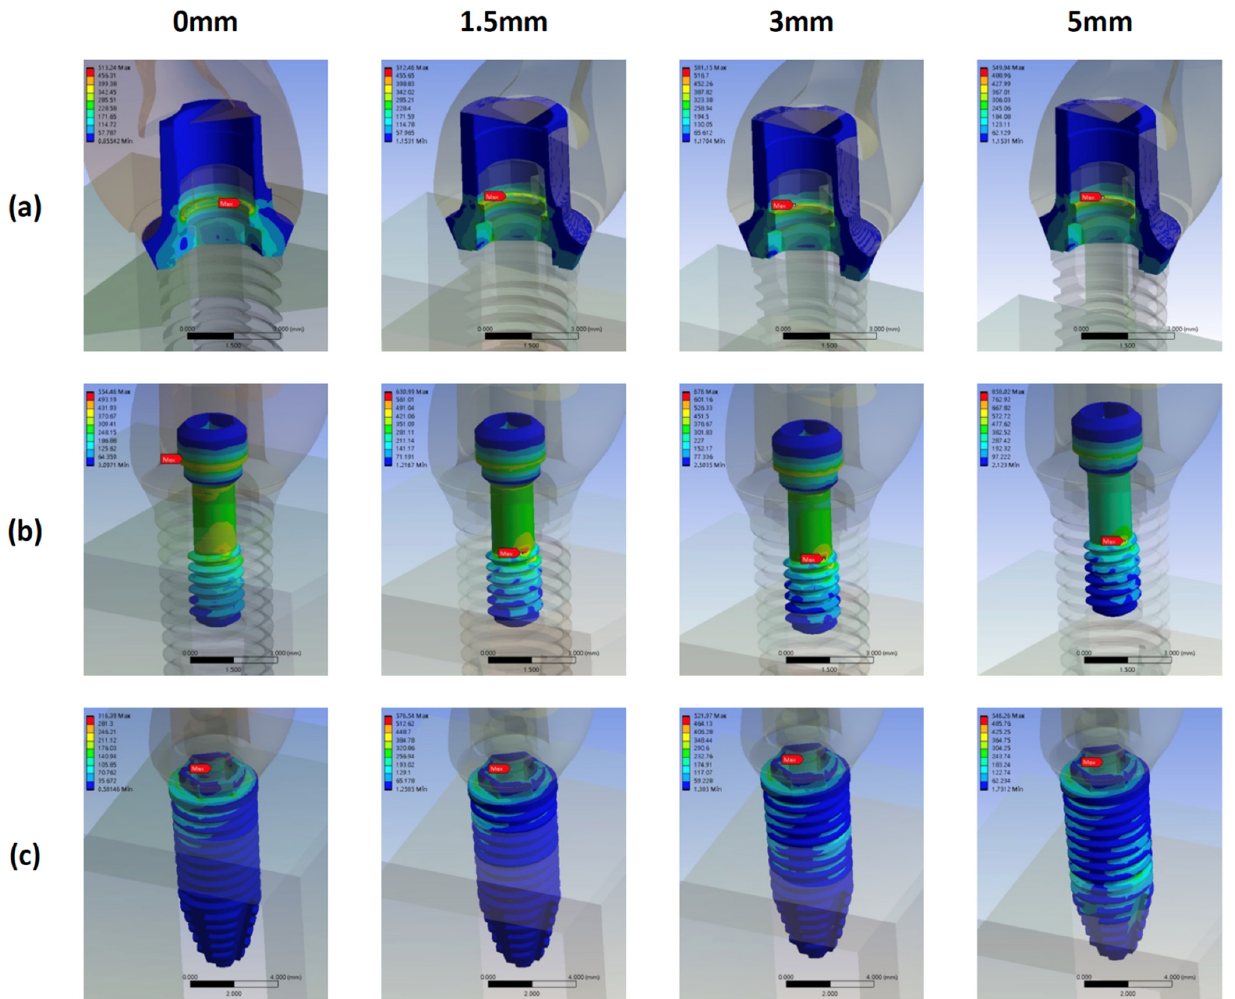
Figure 13. Stress distribution and maximum von Mises stress on the abutments, screws, and fixtures in the SZ groups with different bone loss levels. ( a ) abutment ( b ) screw ( c ) fixture. The stress on the screw increased stably as bone loss increased from 0 to 3 mm; it demonstrated a considerable increase from 676 MPa to 858.02 MPa from 3 to 5 mm. The stress on the fixture first increased significantly from 316.39 MPa in model SZ0 to 576.54 MPa in model SZ1.5, then decreased to 521.97 MPa in model SZ3, and finally, increased slightly to 546.26 MPa in model SZ5. The stress on the abutment in models SZ0 and SZ1.5 was almost identical; it gradu- ally increased to 581.15 MPa in model SZ3 and decreased to 549.94 MPa in model SZ4. The highest stress on the abutment was noted in model SZ3. Finally, the SZ3 model exhibited the highest stress on the bone. 3.5. Stress Distribution Pattern of Each Component of the CZ Model with Different Bone Loss Levels In the CZ models, the highest von Mises stress occurred on the screw, followed by that on the fixture and, finally, by that on the abutment (Figure 14). The locations of max- imum von Mises stress with bone loss progression in the CZ models were almost identical to those in the SZ models (Figure 15).